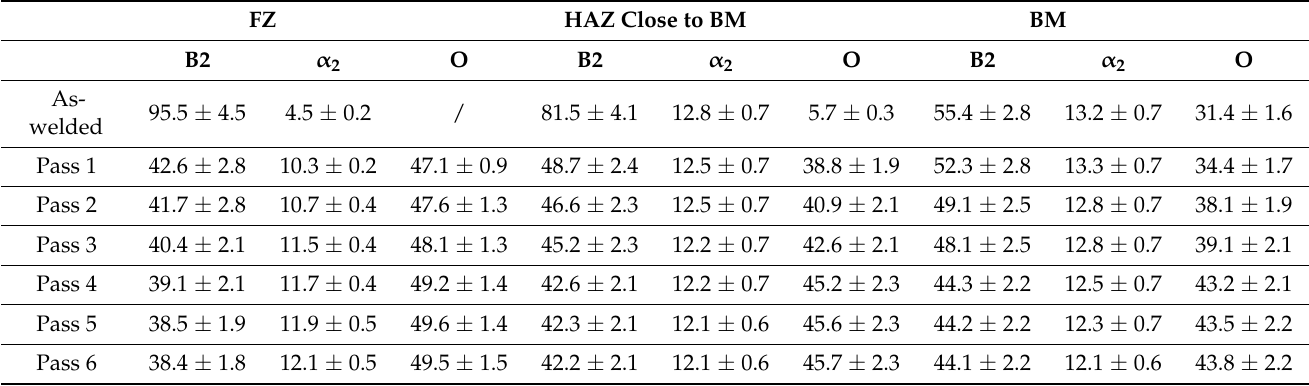
Table 2. Area fraction of α 2 , O and B2 phase in the welded joints (%). (Measured by the Image-Pro Plus